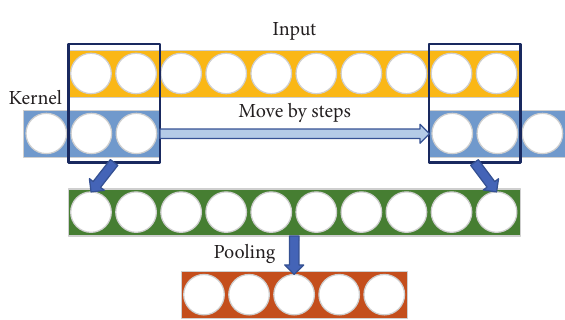
Figure 3: One-dimensional convolution.